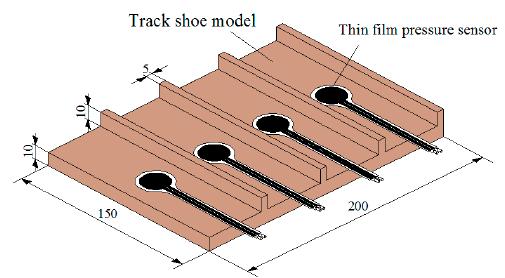
Figure 11. Process of the pressure-sinkage verification test. Figure 12. Track shoe model and pressure sensor.